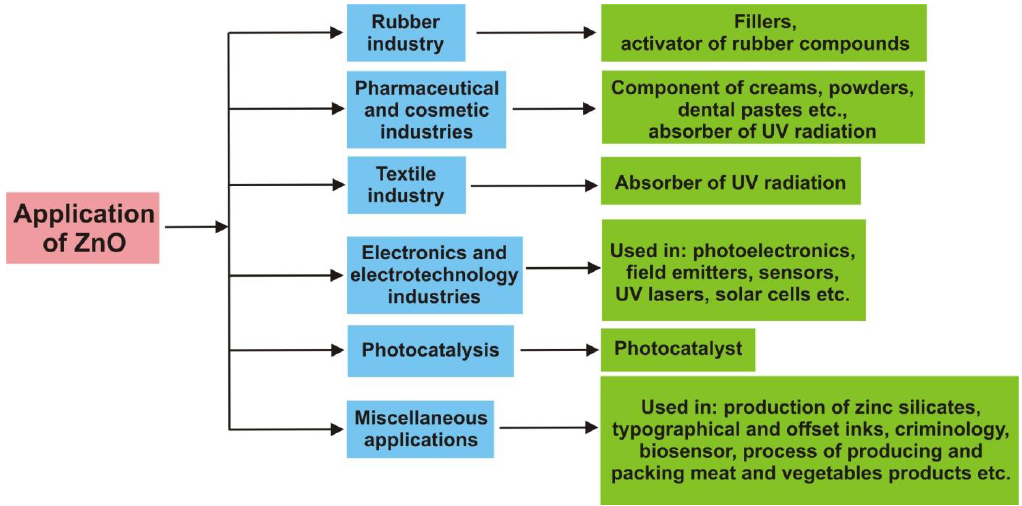
Figure 12. Schematic representation all the application of ZnO mentioned in the